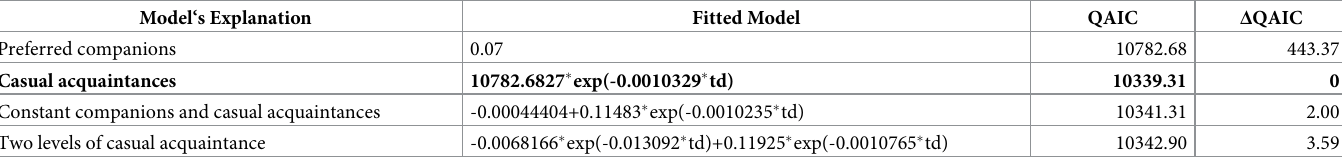
Table 2. Exponential decay models fitted to the standardized lagged association rate among male sperm whales in the Nemuro Strait.